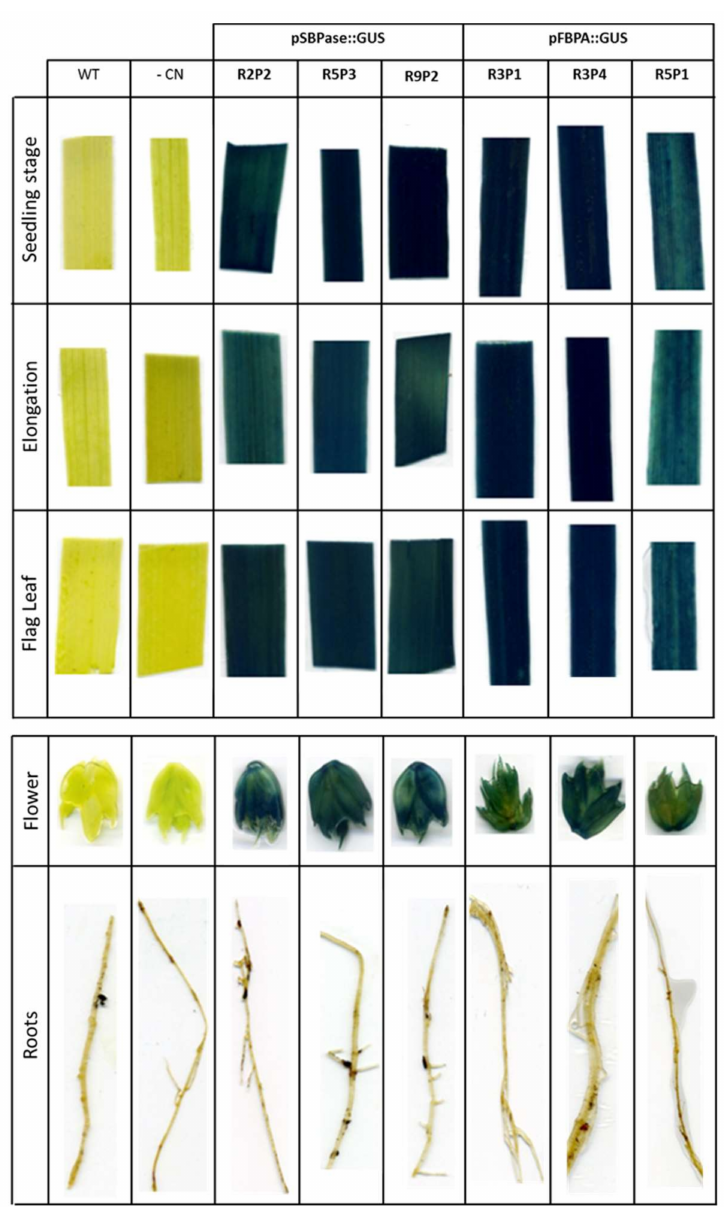
Figure 5. Histochemical analysis of GUS activity in T2 wheat lines stably transformed with the B. distachyon SBPase or FBPA promoter constructs. Leaves were taken for GUS staining at three different growth stages (seedling, elongation and flag leaf) together with samples from different tissues: flowers and roots. Three different lines per promoter were analyzed and compared to WT (wild type) and CN (control plants transformed with bar gene